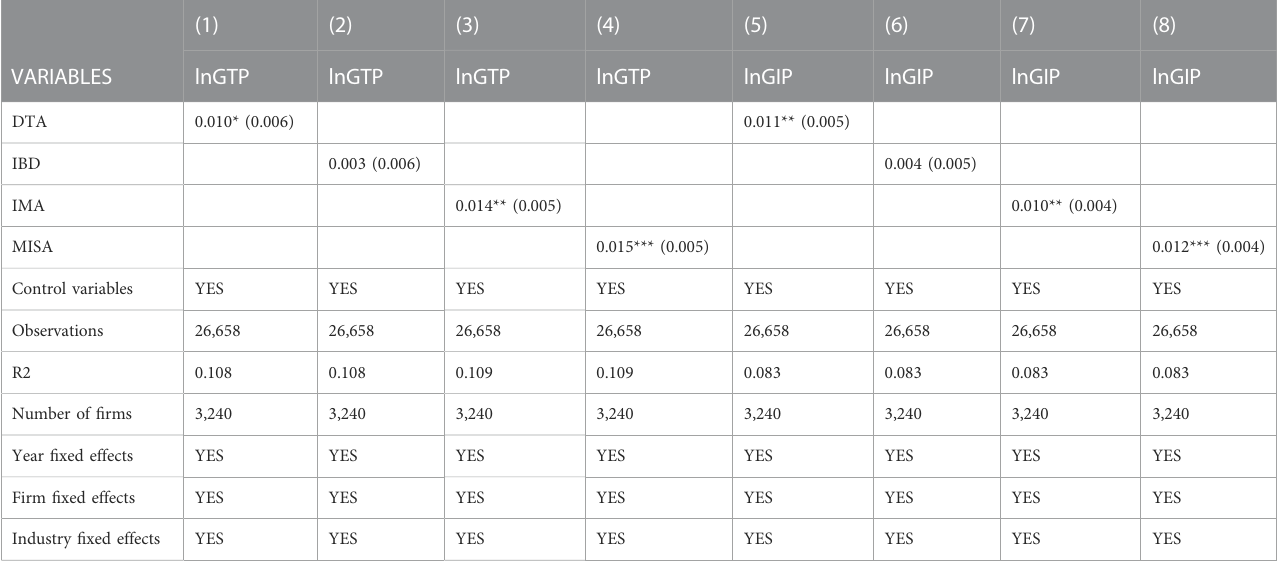
TABLE 11 Digitalization in four